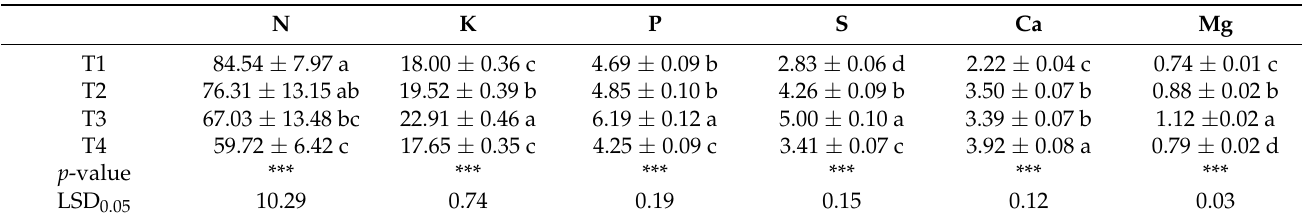
Values are means ± standard deviation ( n = 9). Values with different letters indicate significant differences among treatments. The level of significance was represented as p < 0.001 (***).